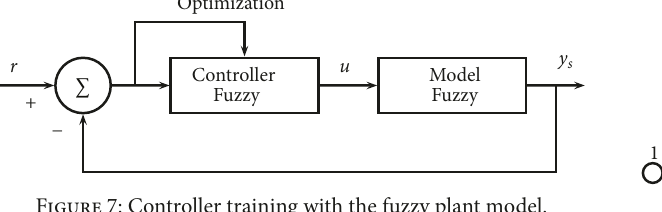
Figure 7: Controller training with the fuzzy plant model.